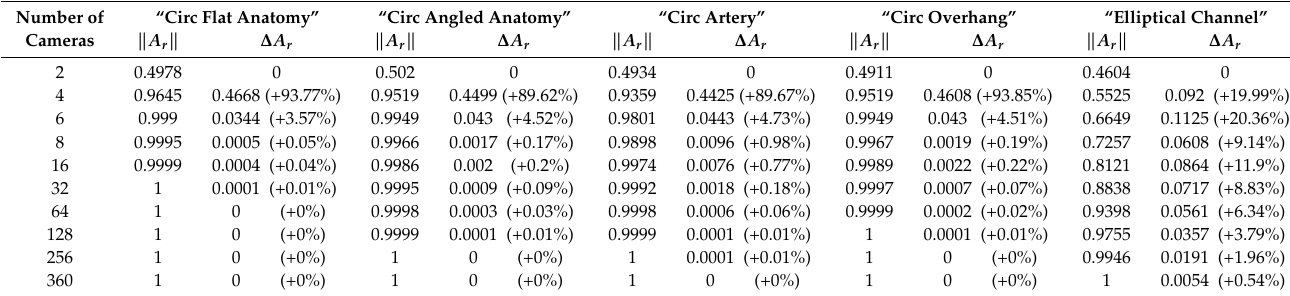
Table 5. Reconstructable areas ( A r ) of the 100mm channel models for different numbers of cameras, excluding the top surface. The area values for each mesh are normalized to the area of the respective mesh which is reconstructable with 360 cameras. ∆ A r denotes the increase in reconstructable area from the next smaller number of cameras. Number of “Circ Flat Anatomy” “Circ Angled Anatomy” “Circ Artery” “Circ Overhang” “Elliptical Channel”